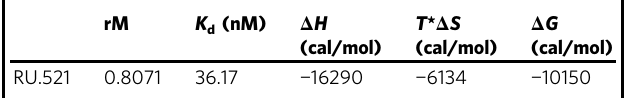
Table 2 Dissociation constant and thermodynamic parameters of RU.521